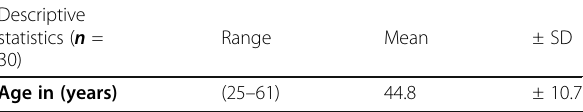
Table 1 Demographic data of the study